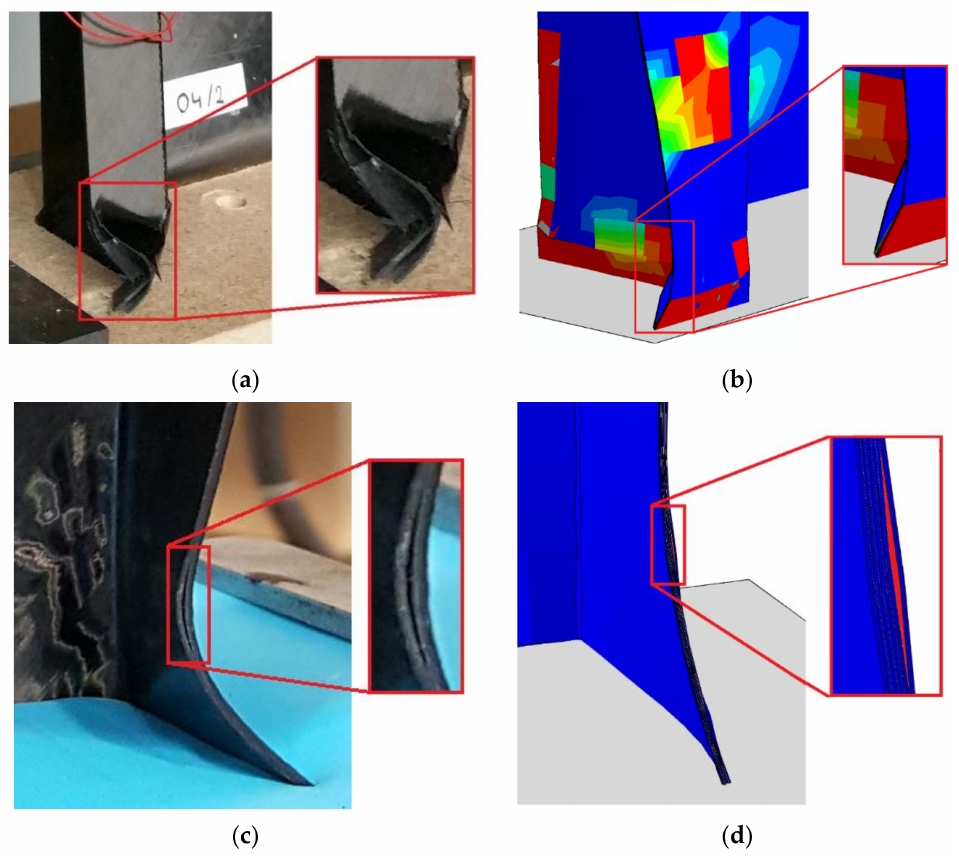
Figure 11. Comparison of delamination regions: ( a ) EXP (top-hat column); ( b ) FEM (top-hat column); ( c ) EXP (channel column); ( d ) FEM (channel column).